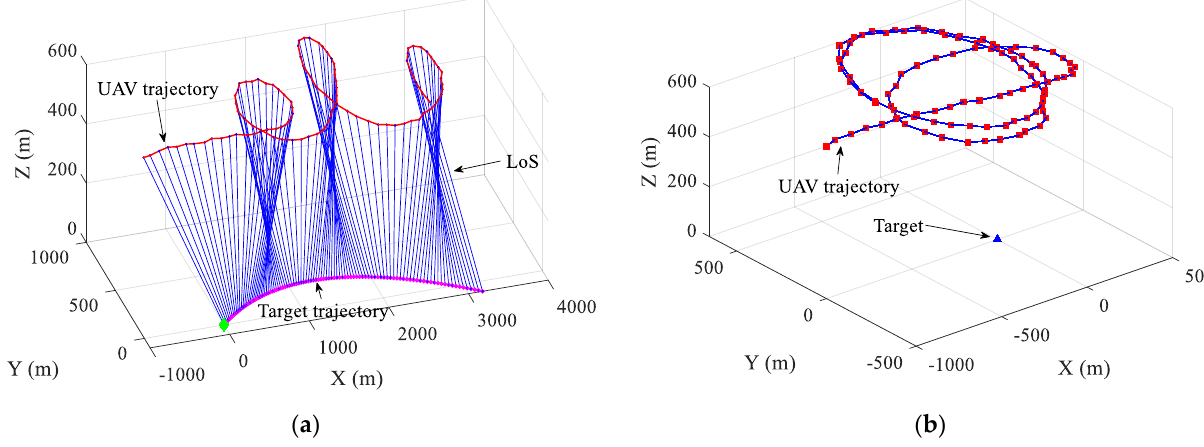
Figure 9. Trajectory optimization result with the constant acceleration motion model. ( a ) Absolute trajectory. ( b ) Relative trajectory with target as the origin.